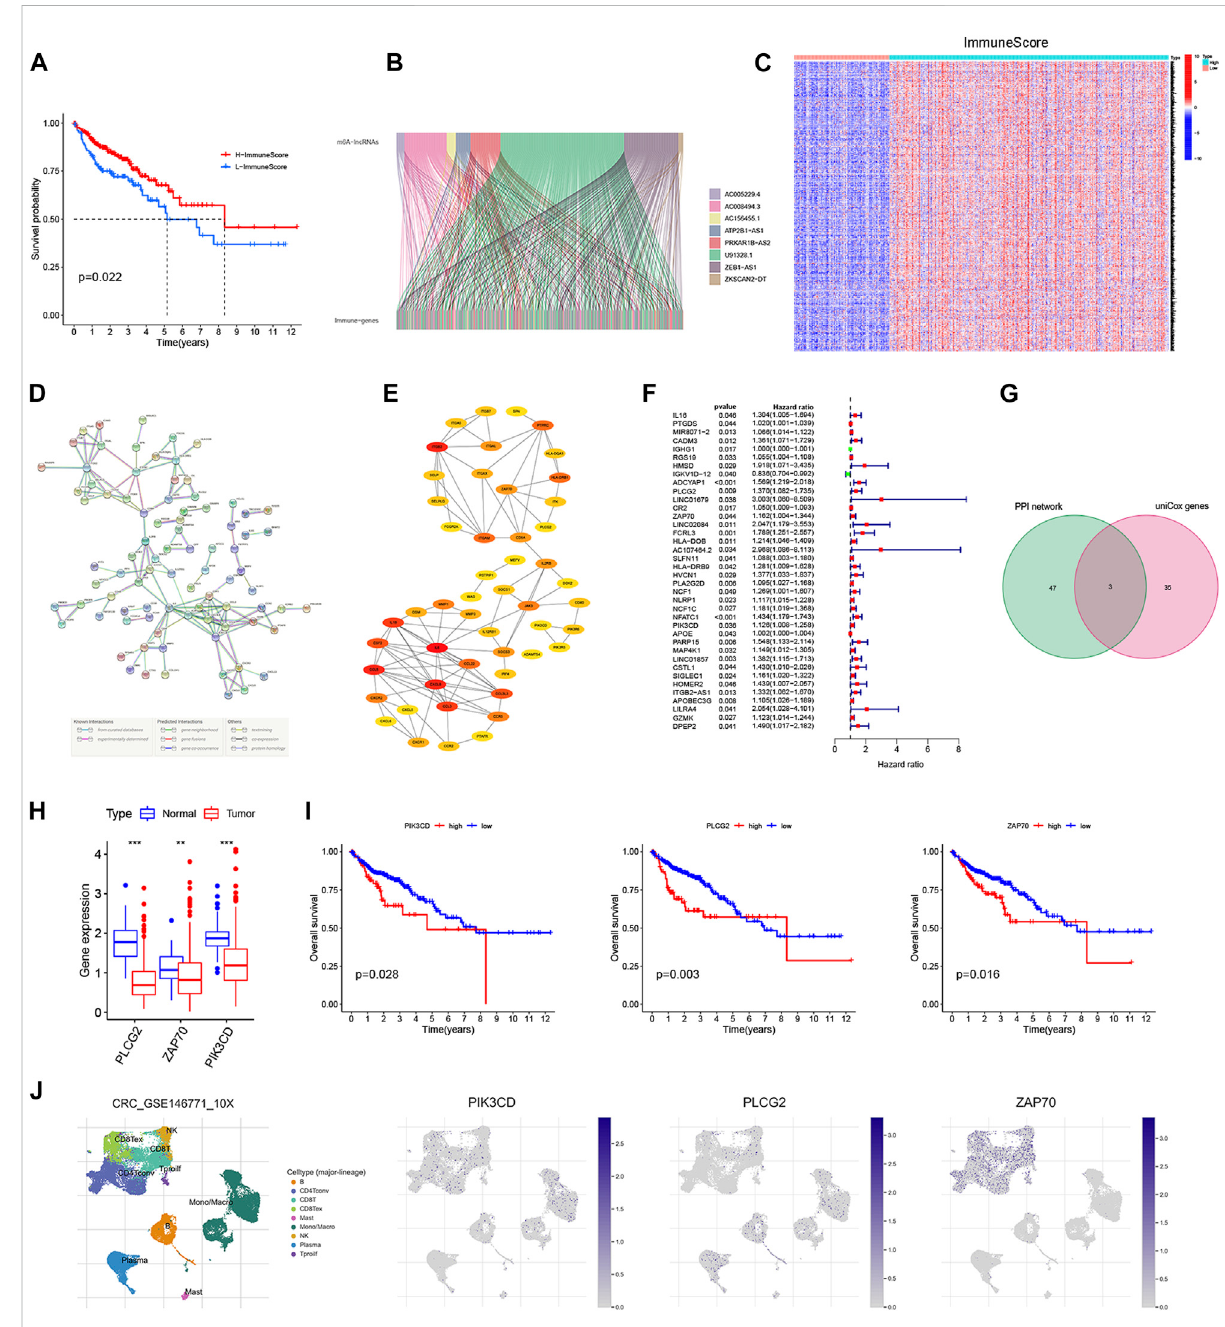
FIGURE 11 Expression distribution of the 3 immune genes in TME of CRC. (A) Kaplan – Meier curves for the high- and low-immunescore with the cut-off value 56.042 of 441 CRC patients. (B) Sankey relational diagram for 8 m6A-related lncRNA signatures and DEIGs. (C) Heatmap for DEIGs generated bycomparisonofthehighscoregroupvsthelowscoregroupinImmuneScore(Rownameofheatmapisthegenename,andcolumnnameistheID of samples which not shown in plot). (D) PPI network showing the interactions of DEIGs (the minimum required interaction score was 0.9). (E) Fiftyhubimmunegenesinthisnetworkwithascoreof > 2. (F) UnivariateCoxregressionanalysiswith458DEIGs,listingthesigni fi cantfactorswith p < 0.05. (G) Vennplotshowingthecommonimmunegenessharedbyleading50nodesinPPIandsigni fi cantfactorsinunivariateCox. (H) Differentiated expression of 3 immune genes in the normal and tumor sample. (I) The OS curve of 3 immune genes for the low- and high-expression groups with the cut-off value 2.896. (J) The association between the expression of PIK3CD, PLCG2 and ZAP70 and the abundance of tumor-in fi ltrating immune cells in CRC based on TISCH. ** p < 0.01; *** p <